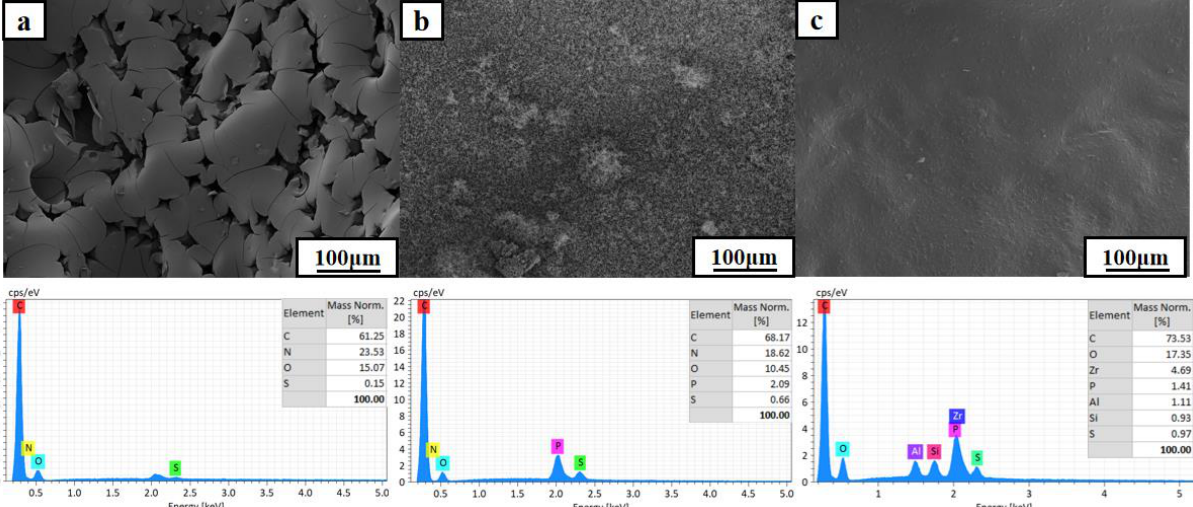
Figure 13. The SEM images and EDS spectra of char residues of EP/DDS ( a ), EP/DDS/HPCP − 9 ( b ), and EP/DDS/HPCP − 6/H − U − 3 ( c ) after cone calorimeter tests.